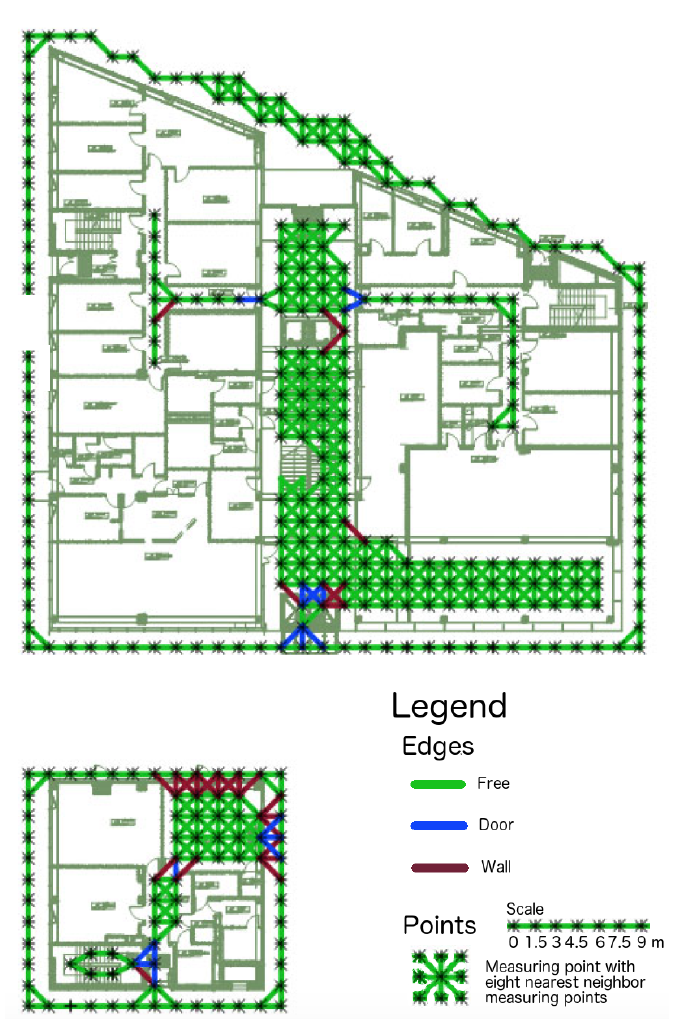
Figure 4. The plan of the first floor of the MIS building with a marked